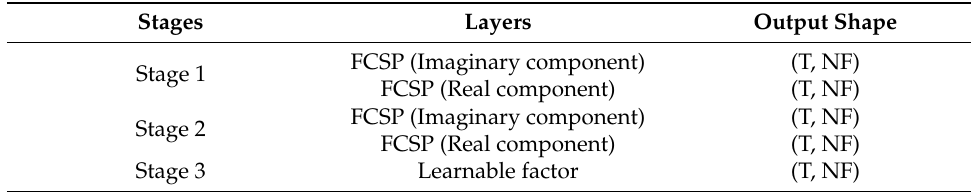
Table 1. Parameters of TFA-ATNN. Stages